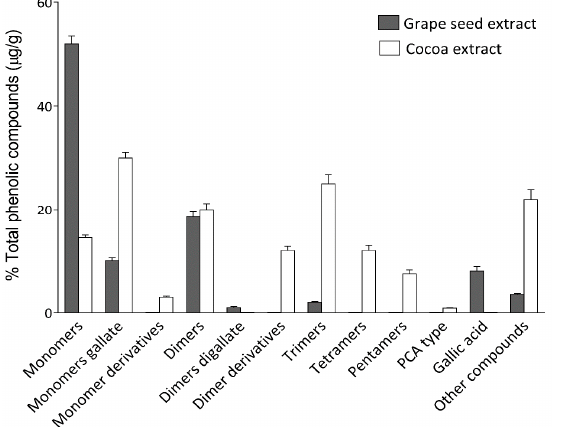
Figure 3. Comparative quantification of main compounds found in cacao and grape seed extracts. Quantitation values are expressed as μ g of analyte per gram of dry extract.